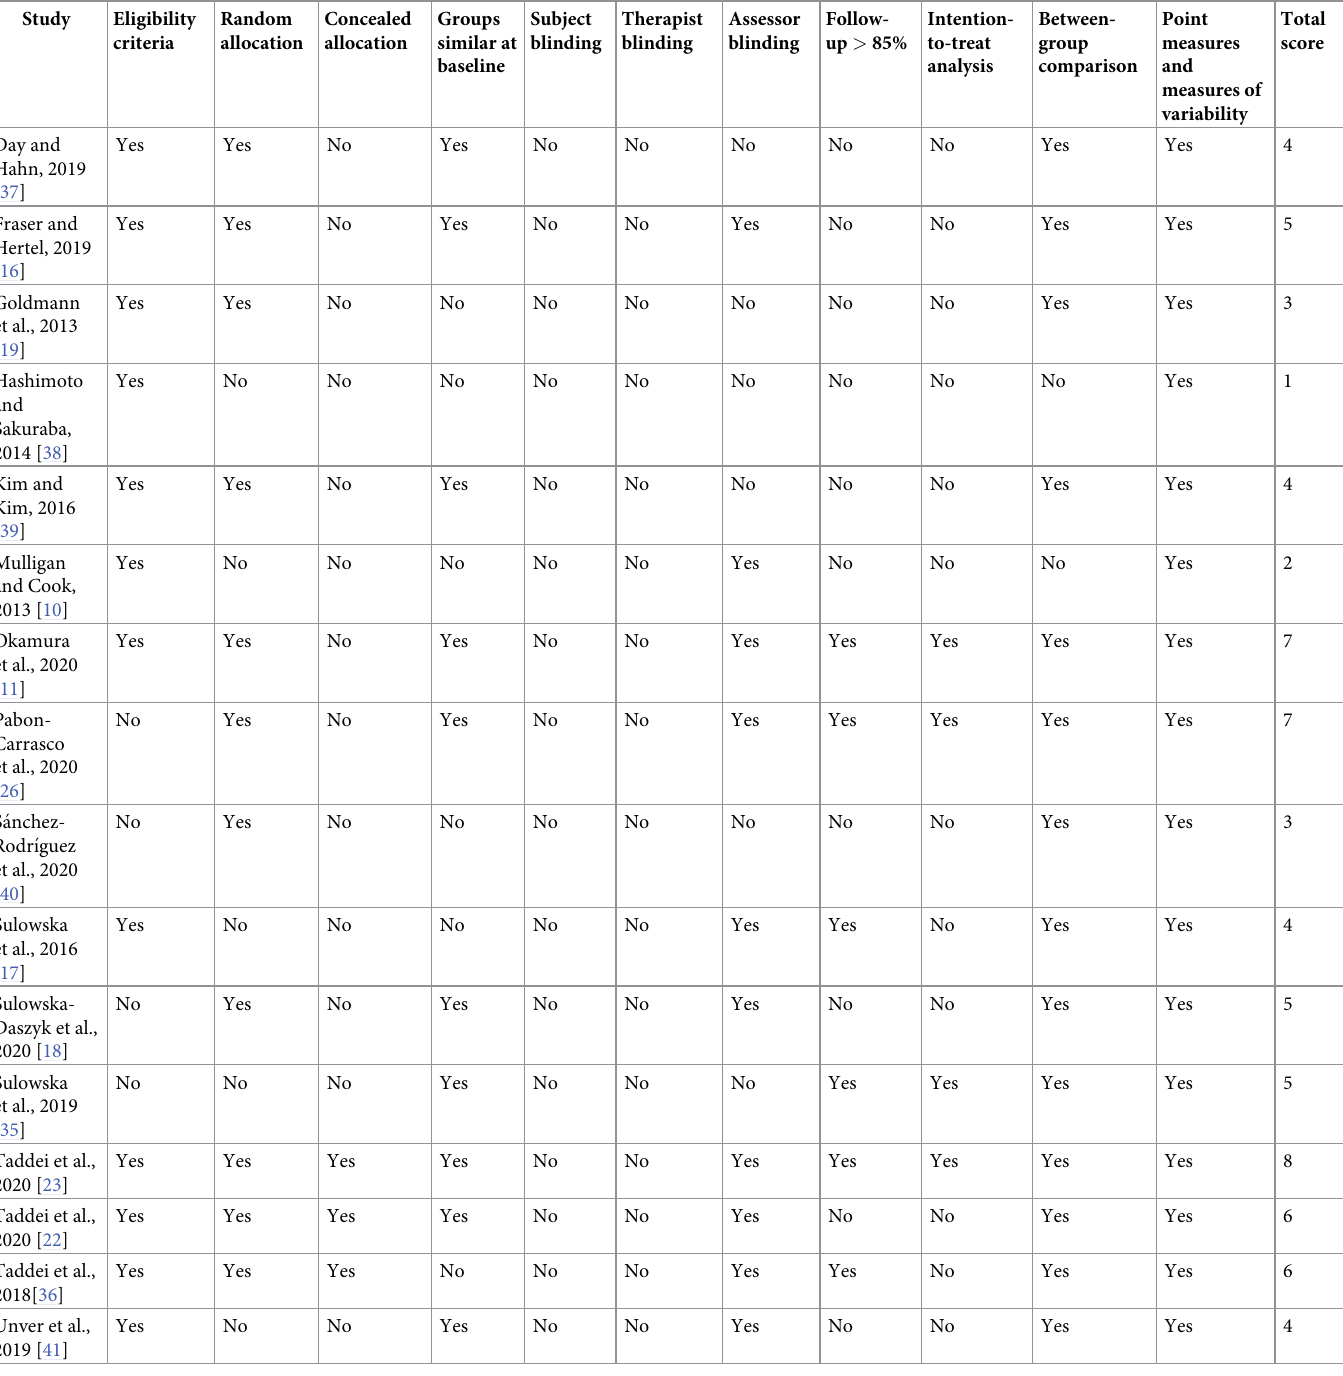
Table 1. Results of the risk of bias assessment using the PEDro scale.